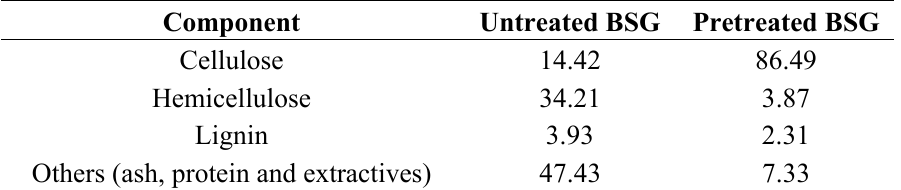
Table 2. Chemical Composition (% w / w ) of untreated, pretreated